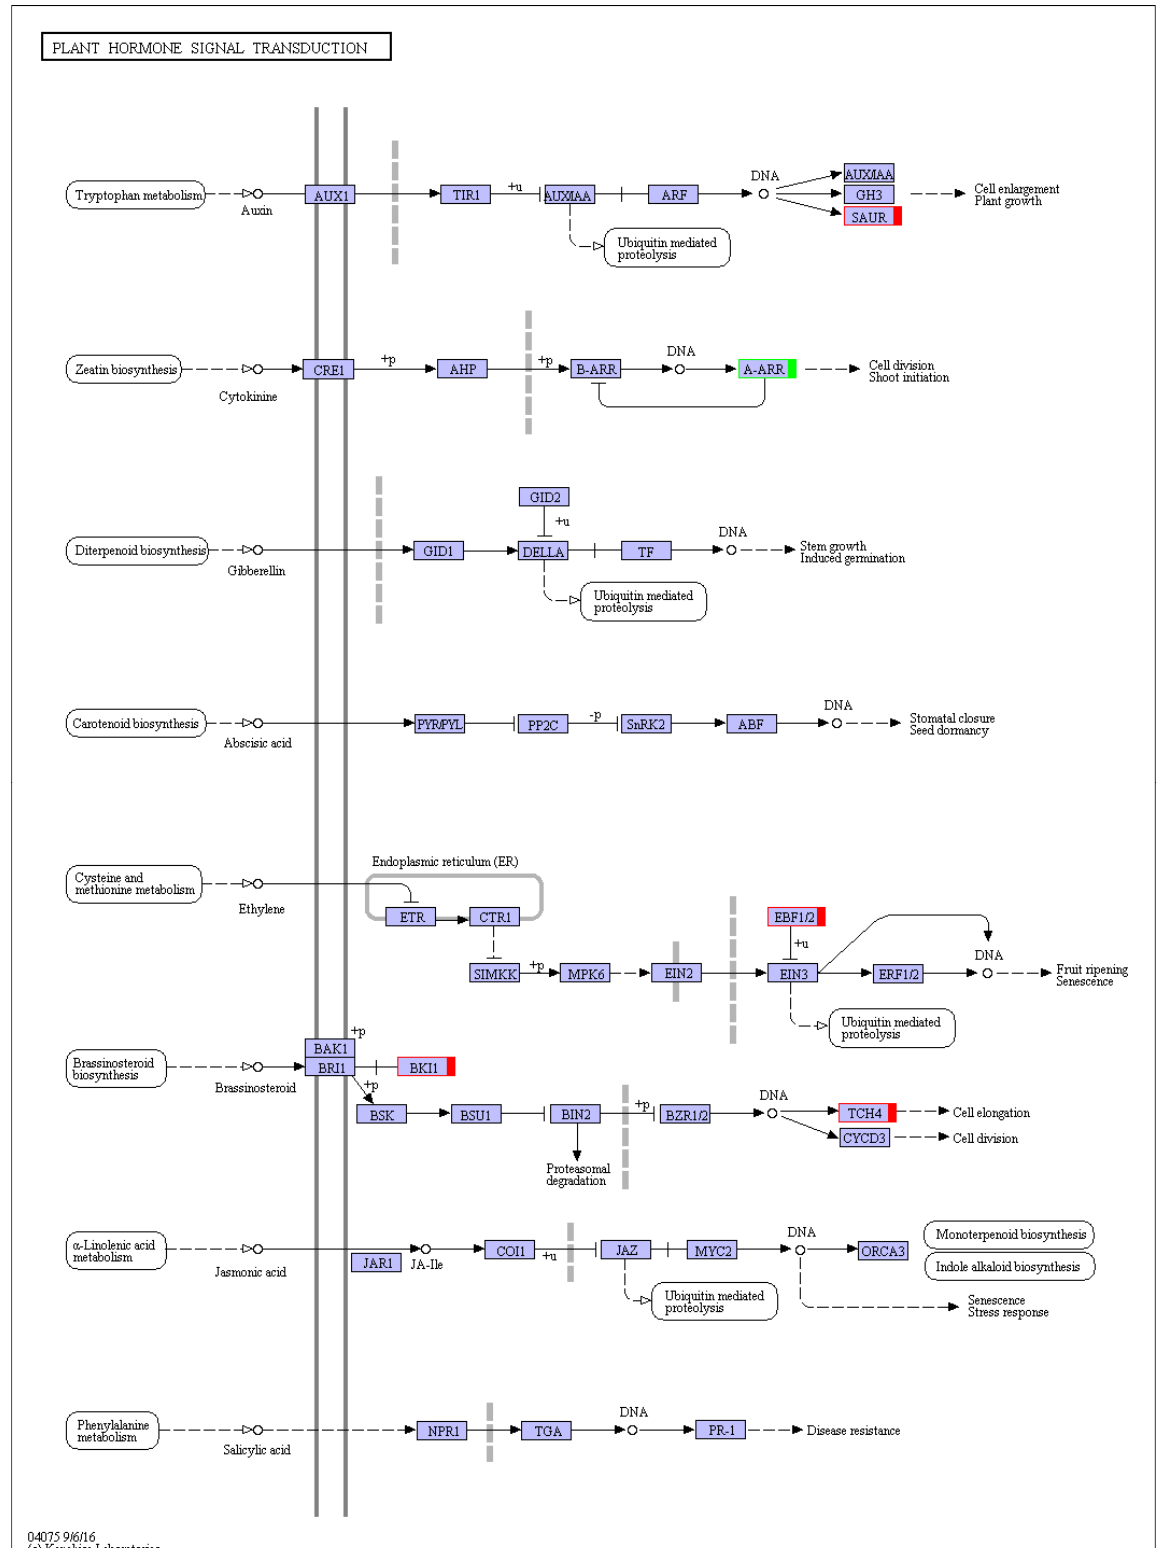
Figure 7. Differentially expressed genes (DEGs) mapped to the plant hormone signal transduction pathway. The red and green box represent upregulated and downregulated encoding genes in the flat stems compared with healthy stems, respectively.